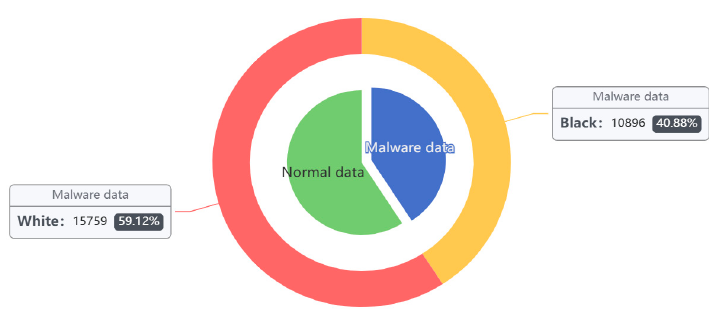
Appl. Sci. 2023 , 13 , 2079 Figure 10. Sample distribution after DataCon dataset expansion. Figure 10. Sample distribution after DataCon dataset expansion. Figure 10. Sample distribution after DataCon dataset expansion.